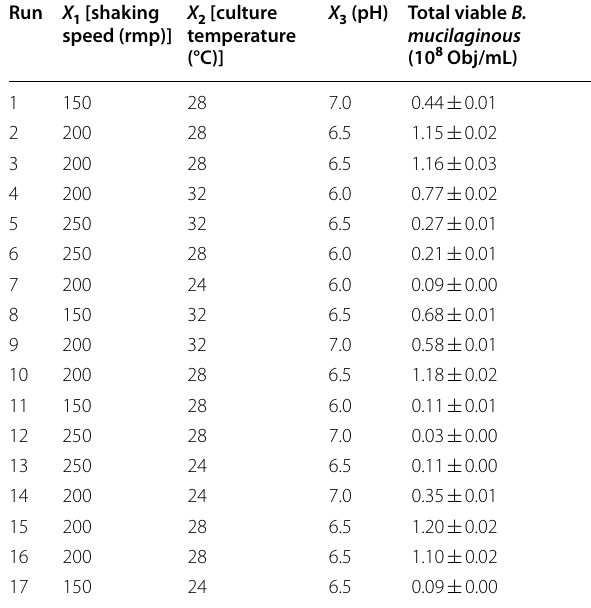
Table 4 Experimental design of steepest ascent Table 5 Box–Behnken